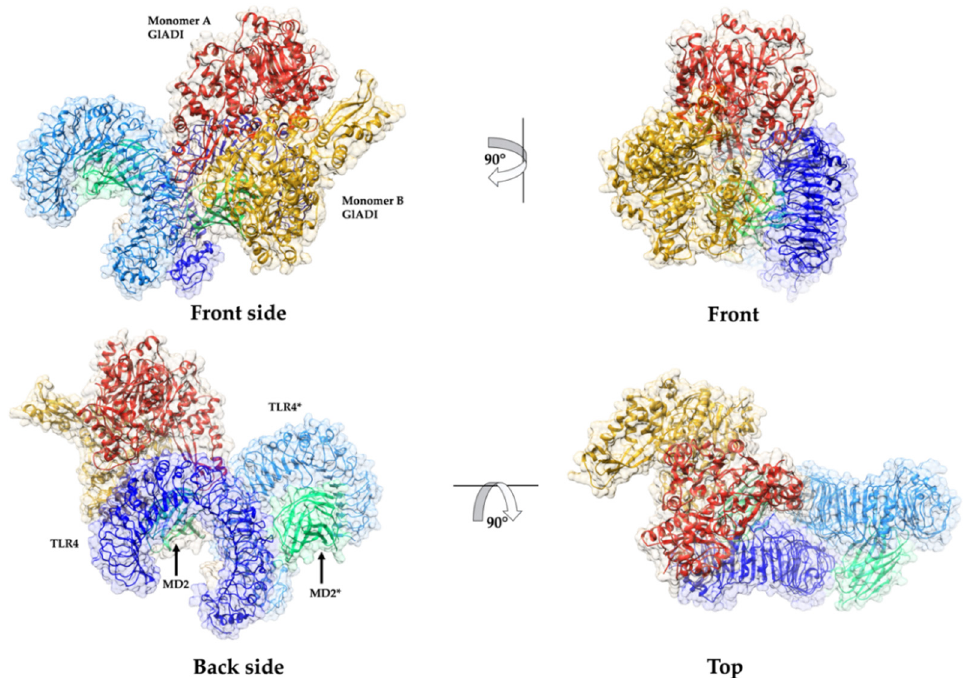
Figure 7. Predicted interactions between AlphaFold-predicted structure of GlADI and the ectodomain of human TLR4 in complex with MD-2. Ribbons combined with surface representation show four different views of the docking prediction between GlADI and TLR4-MD2 tetramer. Structures displayed with UCSF Chimera.